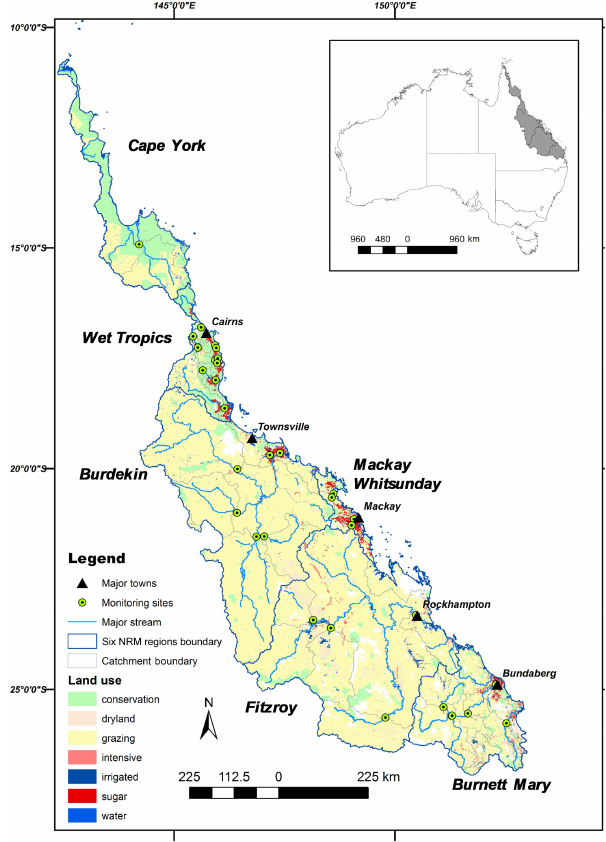
Figure 1. The Great Barrier Reef (GBR) catchments, monitoring sites, land uses and the six natural resource management (NRM) regions. Land uses have the following characteristics: (1) con- servation (forest, woodland, savannah, etc., for conservation pur- poses), (2) dryland (rainfed agriculture, including cereals but ex- cluding grazing and sugar cane), (3) grazing (primarily cattle graz- ing of native and introduced vegetation), (4) intensive (urban areas, roads, etc.); (5) irrigated (irrigated cropping, excluding sugar cane); (6) sugar (rainfed and irrigated sugar cane) and (7) water (water bodies, including lake, river and